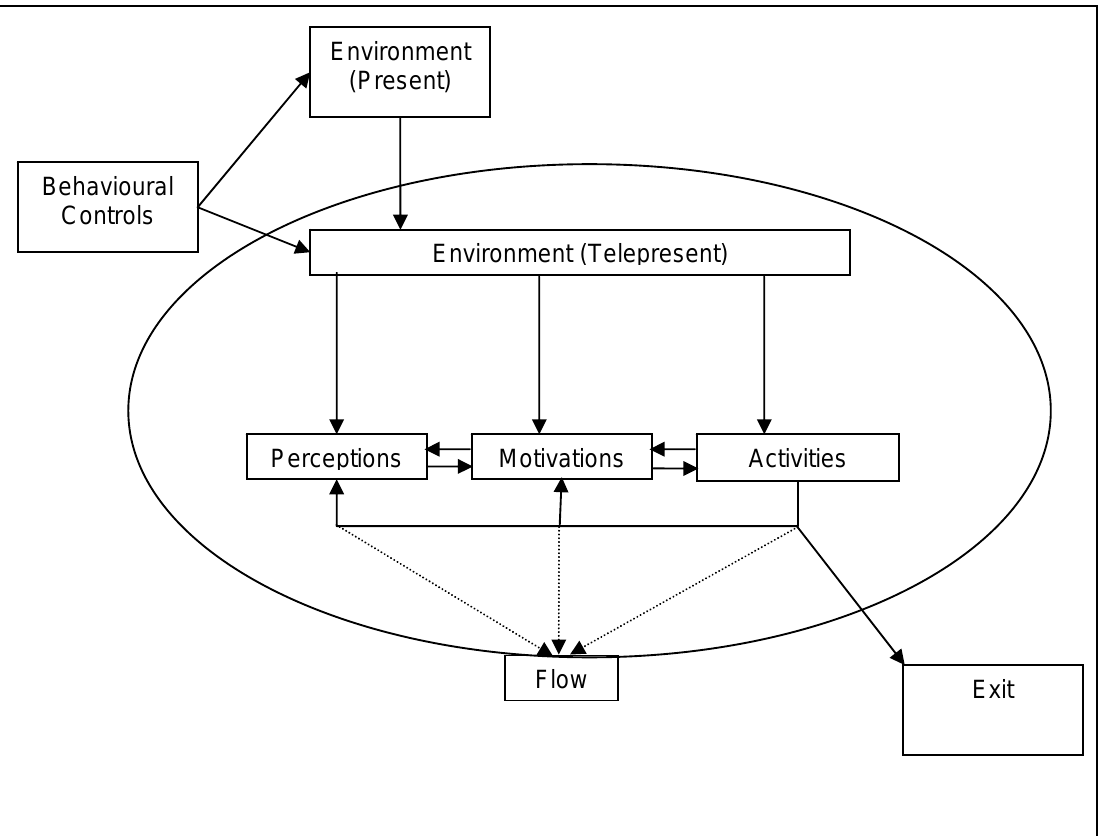
Figure 1: The extended model of